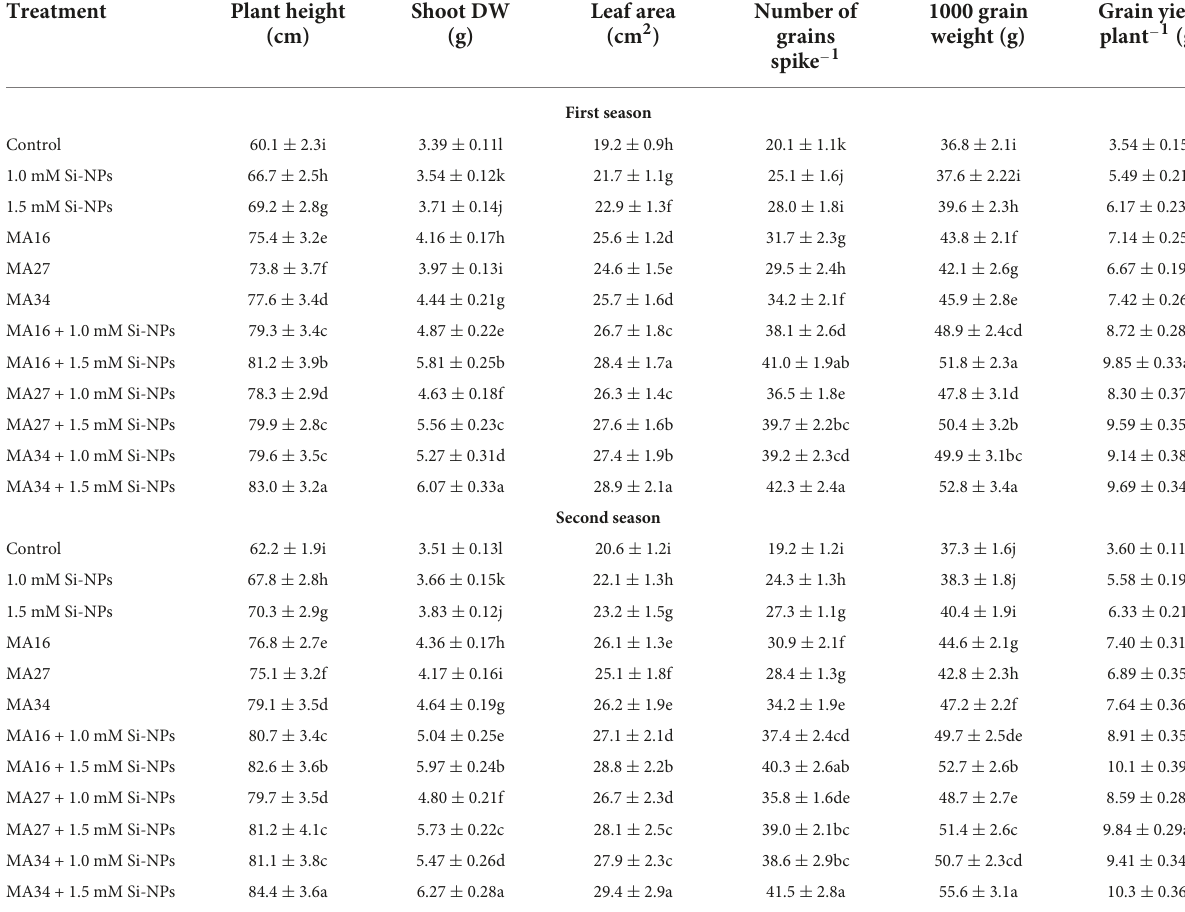
Dataaremeans ± SE.Withincolumns,valuesfollowedbydifferentlettersaresignificantly( p >